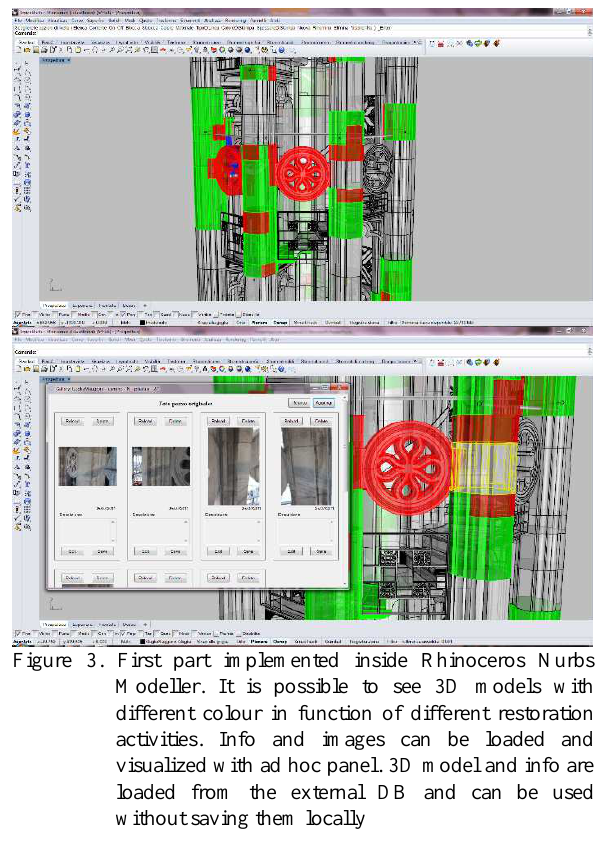
Figure 3. First part implemented inside Rhinoceros Nurbs Modeller. It is possible to see 3D models with different colour in function of different restoration activities. Info and images can be loaded and visualized with ad hoc panel. 3D model and info